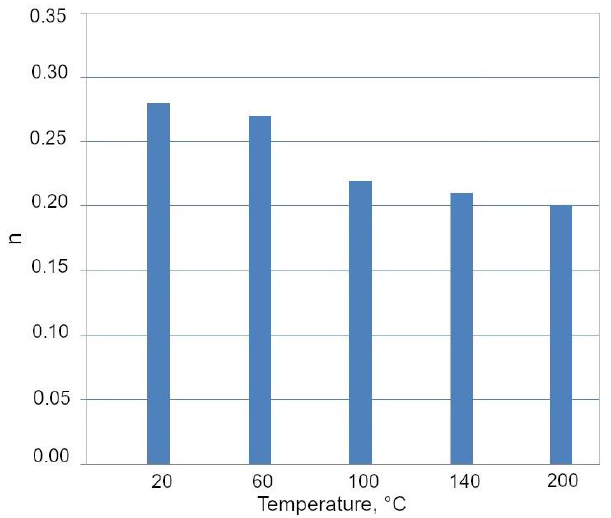
Figure 12. The highest n values at different deformation temperatures.